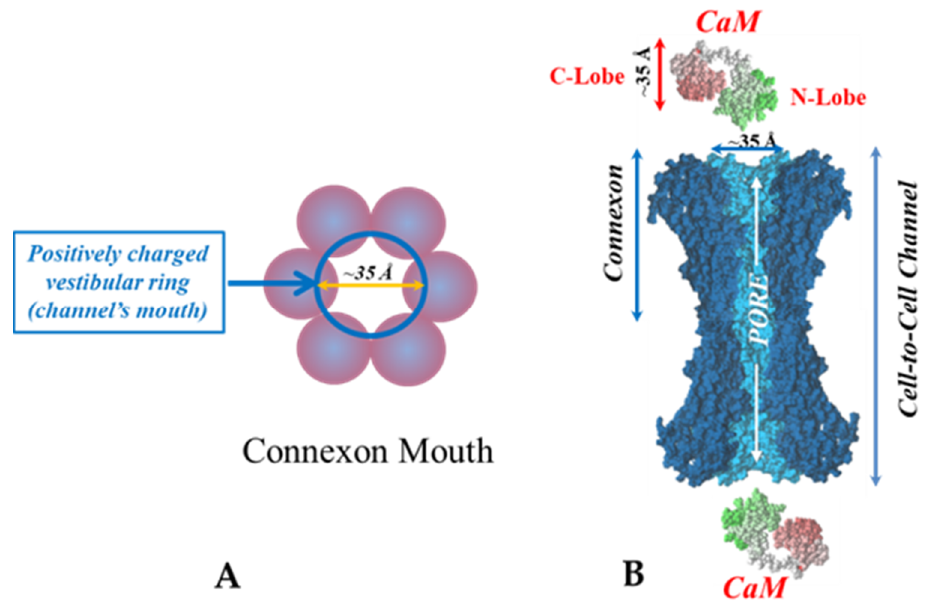
Figure 9. Both the positively charged channel’s mouth ( A ) and the negatively charged CaM lobes ( B ) are ~35 Å in diameter. Therefore, a CaM lobe could fit well in the channel’s mouth (vestibule) and electrostatically interact with it. In B, the channel is split along its length to display the pore diameter (light blue area) along the channel’s length. Both CaM and connexon images ( B ) were provided by Dr. Francesco Zonta (Venetian Institute of Molecular Medicine, VIMM, University of Padua, Italy).